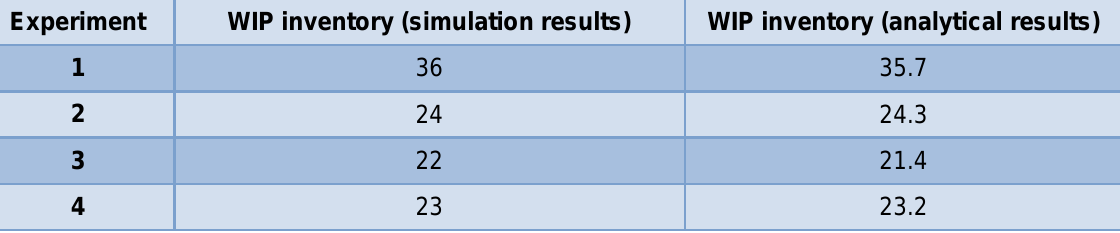
Table 3 Verification of the outputs (Quantitative comparison of simulation and analytical